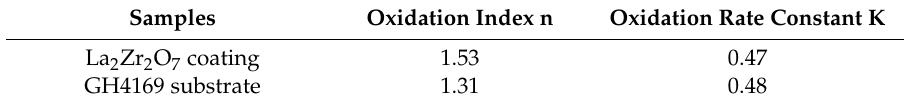
Table 4. Oxidation rate constant K and oxidation index n of the coating and